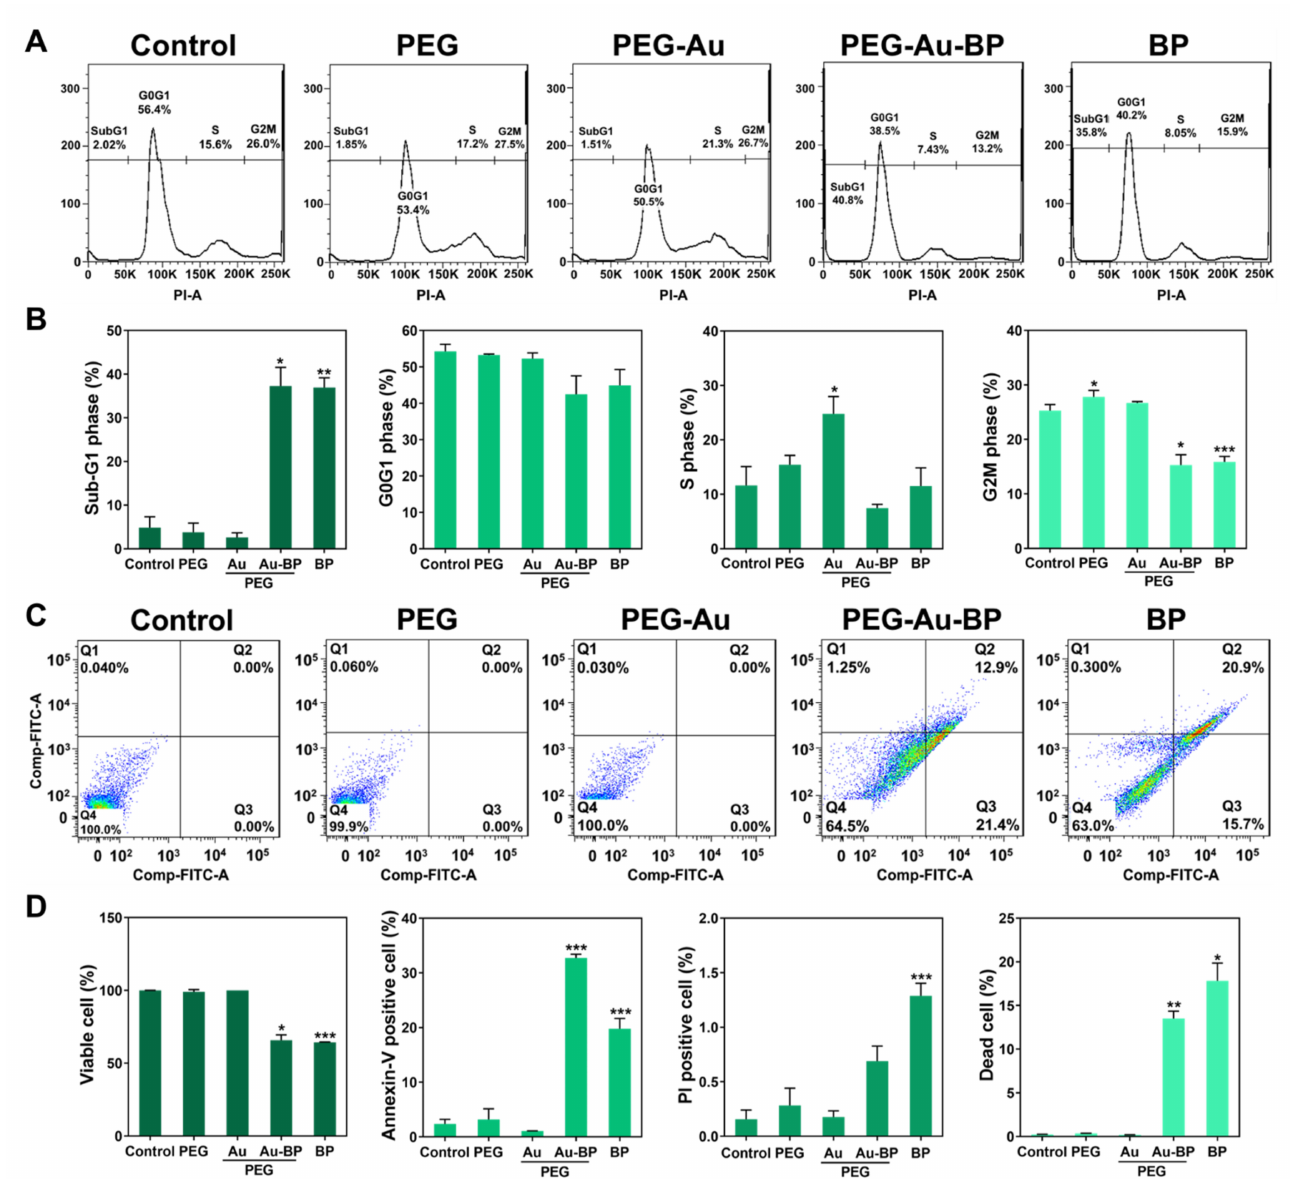
Figure 7. Cell apoptosis of DBTRG brain cancer cells after being treated with various nanoparticles for 48 h. ( A ) The cell cycle histograms of DBTRG cells affected by PEG-Au-BP were obtained from flow cytometry. ( B ) Sub-G1 phase indicates the cell apoptosis. Based on the quantification results, PEG-Au-BP (37.25%) and BP (36.92%) treatments had the higher percentage of apoptotic DBTRG cells than the other groups. To further determine the population of apoptotic DBTRG brain cancer cells after 48 h of each treatment, Annexin-V/PI double staining assay was applied for the investigation. ( C ) The histograms obtained by flow cytometry were demonstrated. ( D ) The population was further quantified, while the viable cells in the PEG-Au-BP group (63.2%) and BP group (61.7%) were significantly lower than the other groups. The apoptotic cells as well as Annexin-V-positive cells in the PEG-Au-BP group (31.5%) and BP group (19.3%) were remarkably higher than the others. The above evidence indicates that PEG-Au-BP could be a potential anti-cancer nanodrug. The data were represented as the mean ± SD ( n = 3). * p < 0.05, ** p < 0.01, *** p < 0.001: compared to the control